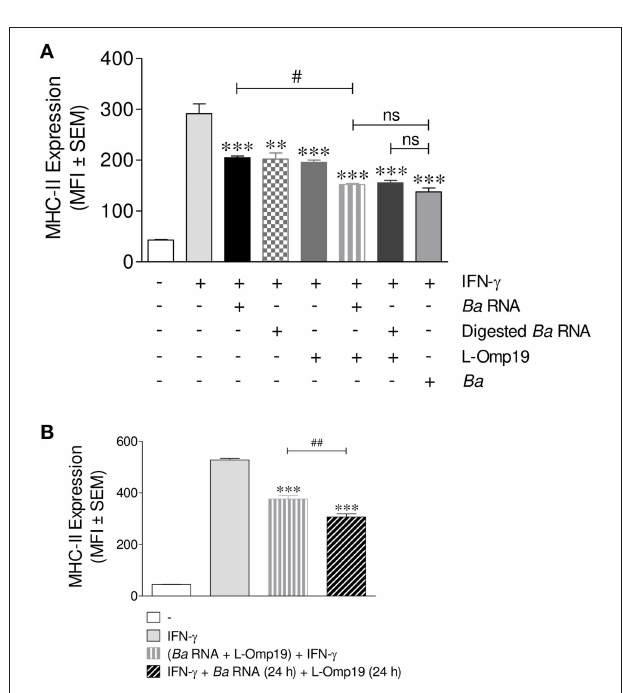
FIGURE 5 | B. abortus RNA and B. abortus L-Omp19 act synergistically in MHC-II inhibition. (A) THP-1 cells were infected with B. abortus (MOI 100:1) or treated with B. abortus RNA (10 µ g/ml), digested B. abortus RNA, L-Omp19 (1 µ g/ml) or their combination in the presence of IFN- γ for 48h. (B) THP-1 cells were treated with IFN- γ and B. abortus RNA (5 µ g/ml) for 24h. Afterwards, L-Omp19 (1 µ g/ml) was added for other 24h. THP-1 cells treated with both stimuli simultaneously were used as control. MHC-II expression was assessed by flow cytometry. Bars represent the arithmetic means ± SEM of five independent experiments. MFI, mean fluorescence intensity; ns, non-significant. ** P < 0.05; *** P < 0.001 vs. IFN- γ -treated cells; # P < 0.05 vs. Ba RNA + IFN- γ ; ## P < 0.01 vs. ( Ba RNA + L-Omp19) + IFN- γ